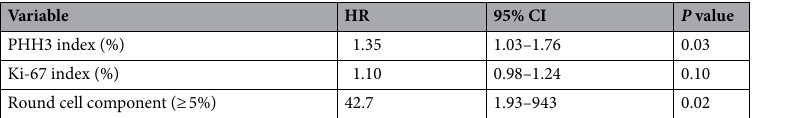
Table 4. Multivariate analysis using the Cox proportional-hazard regression analyses. PHH3 Phosphohistone H3, HR Hazard ratio, CI Confidence interval.